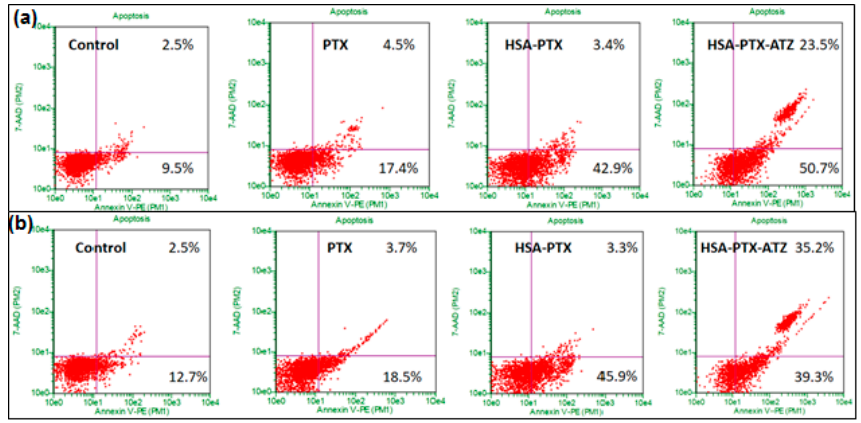
Figure 7. Apoptosis assay studies in ( a ) MDA-MB-231 and ( b ) MDA-MB-468 for the hypoxia targeting drug delivery system HSA-PTX-ATZ (The results are presented in terms of percentage of apoptotic cells similar to the previous literature